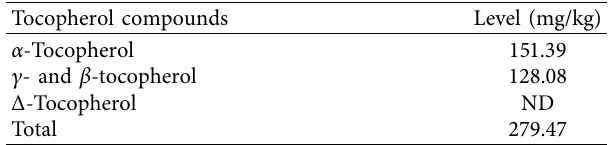
Table 2: Tocopherol compounds in the methanolic extract of C.